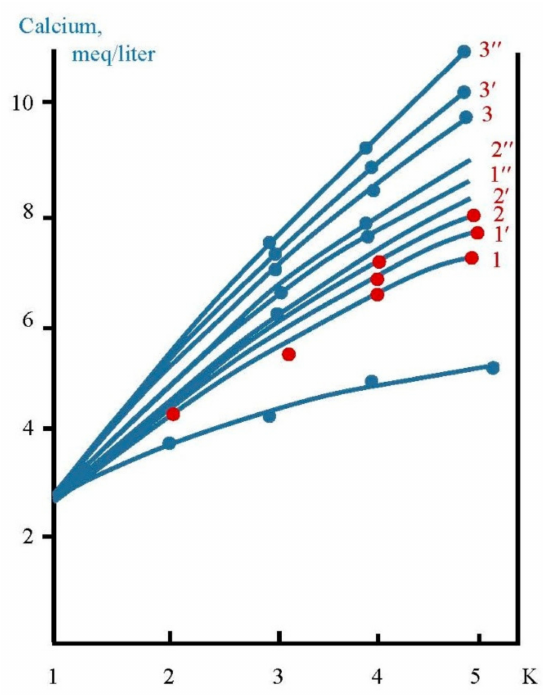
Figure 5. Dependencies of calcium ion concentration values on K during experiments: 1—Jurbysoft,